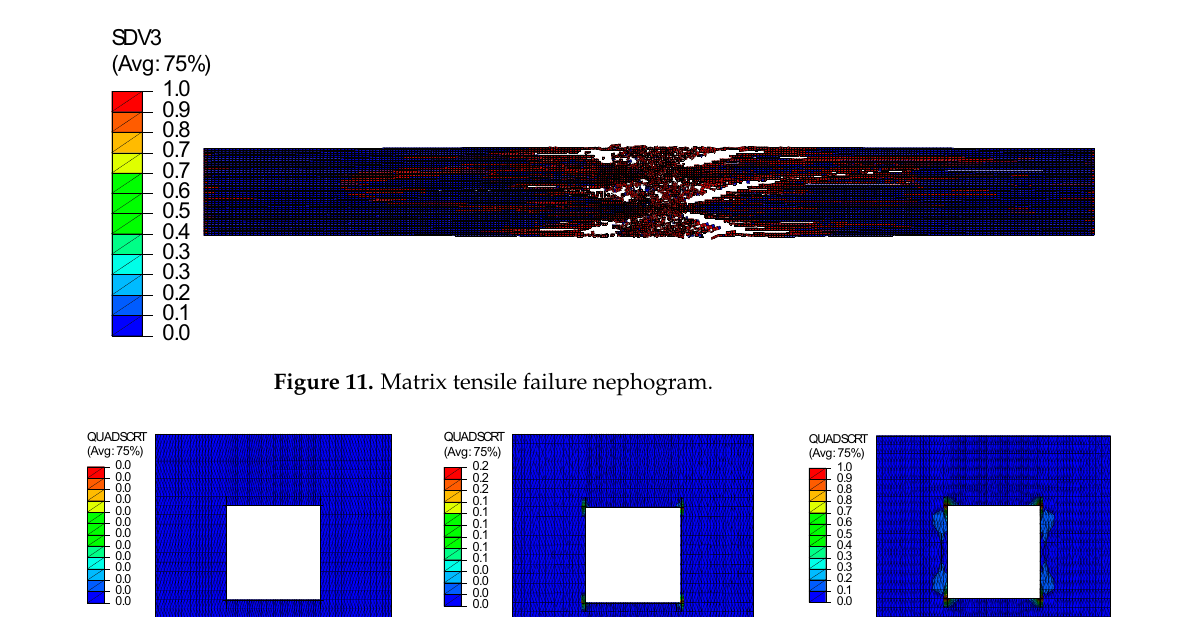
13 of 20 Figure 10. Load–displacement curve of specimen A1 on the basis of test and simulation results. Matrix tensile failure and interlaminar delamination damage were the main failure modes of the prefabricated laminates with delamination under tensile load. Figure 11 pre- sents the final matrix tensile failure nephogram of the UD layer. It can be clearly seen that the matrix experienced complete failure, which is consistent with the complete separation of fibers into explosions observed in Figure 6a. The failure factor nephograms of the de- lamination damage propagation area at six load steps are extracted in Figure 12. With increasing load, the prefabricated delamination extends to the surrounding area, until complete failure of the damage propagation area occurs. At that time, the maximum load- ing capacity of the laminate had not been reached, and the tensile load continued to in-